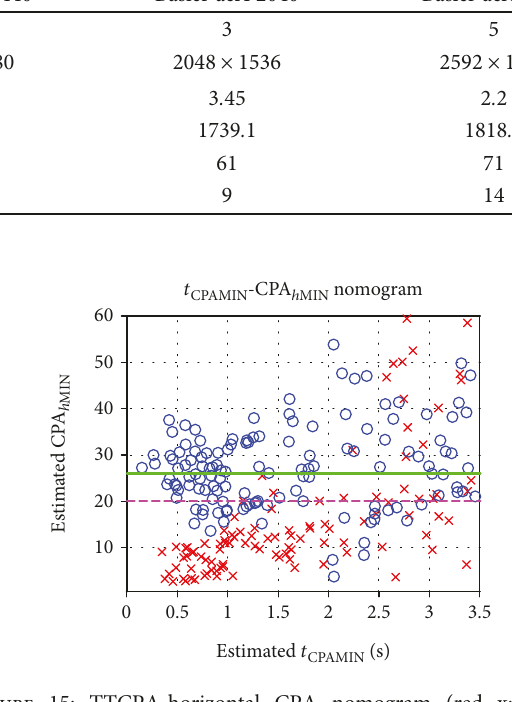
Figure 15: TTCPA-horizontal CPA nomogram (red x: close encounters; blue circle: far encounters).